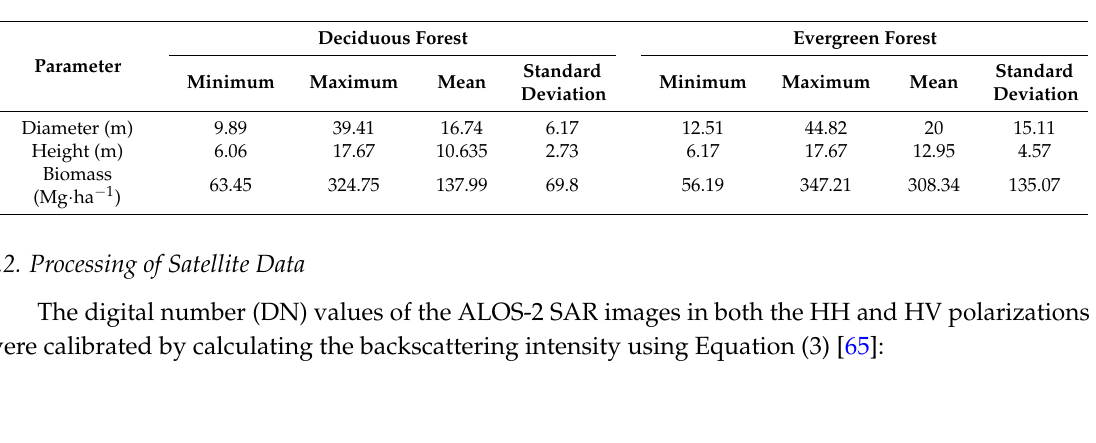
Table 5. Forest inventory parameters for the validation